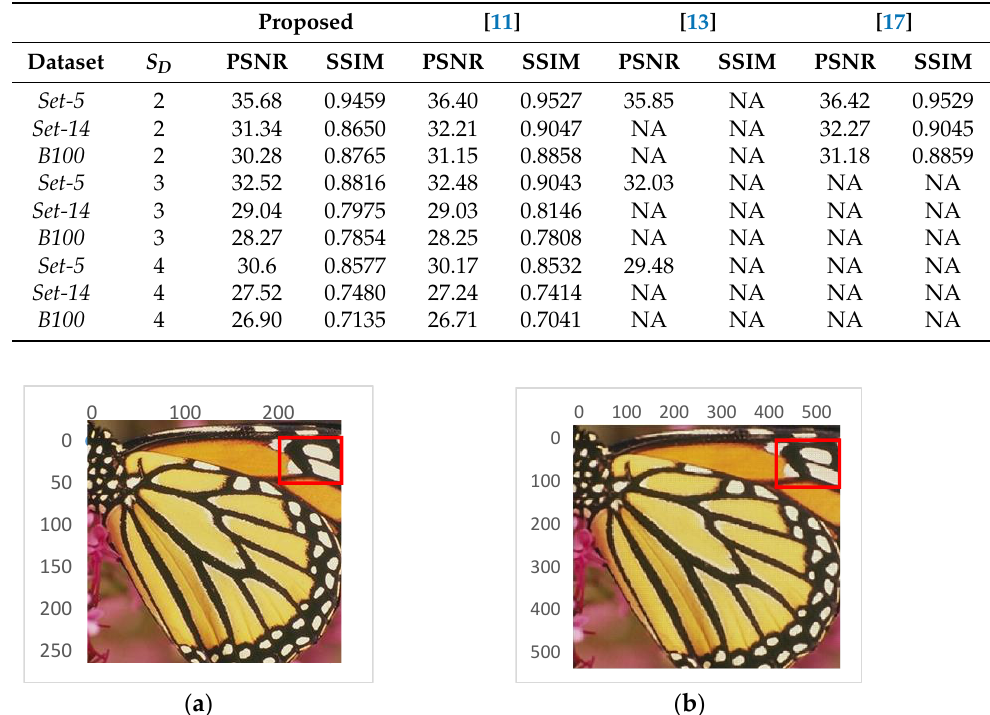
Figure 10. Sample results obtained with S D = 2: ( a ) The original image (from the public dataset Set-5 http://mmlab.ie.cuhk.edu.hk/projects/FSRCNN.html (accessed on 25 August 2021) [28]); ( b ) the reconstructed image.